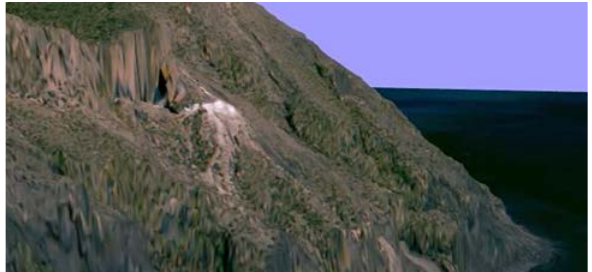
Fig. 10: DOP Luting due to steepness in a 3D visualization of a DOP